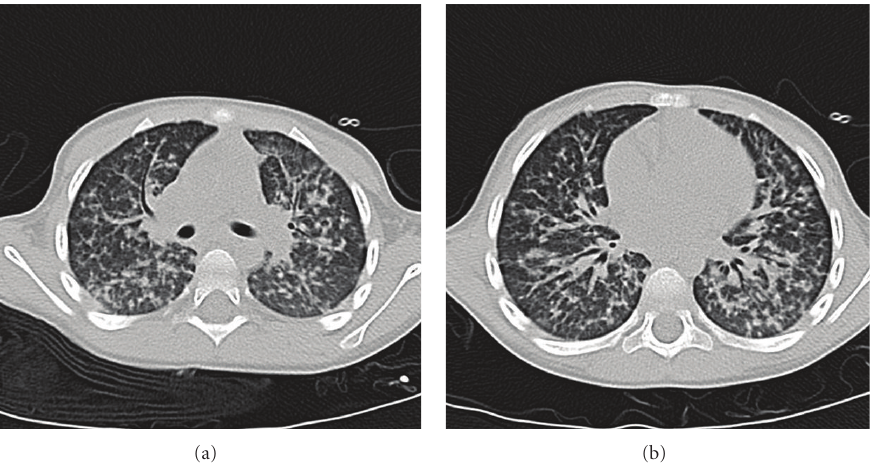
Figure 3: Chest CT prior to admission. Imaging showing di ff use nodular pattern involving di ff erent areas of the lungs. There is absence of air trapping or bronchiectatic changes usually seen when there is concurrent involvement of the conductive airways. These images were obtained at the age of 3 years during initial episode of pneumonia.